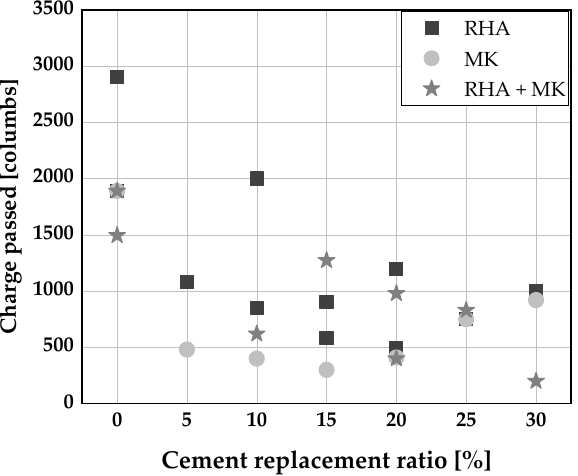
Figure 13. Rapid chloride penetration of SCC produced with RHA and/or MK [110].